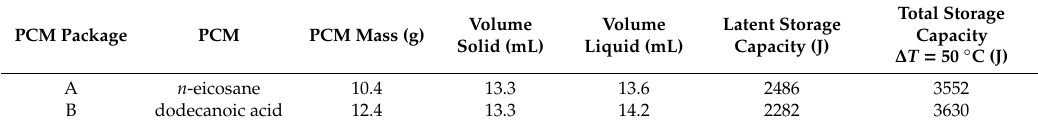
Table 3. PCM package and thermal spreader used in the